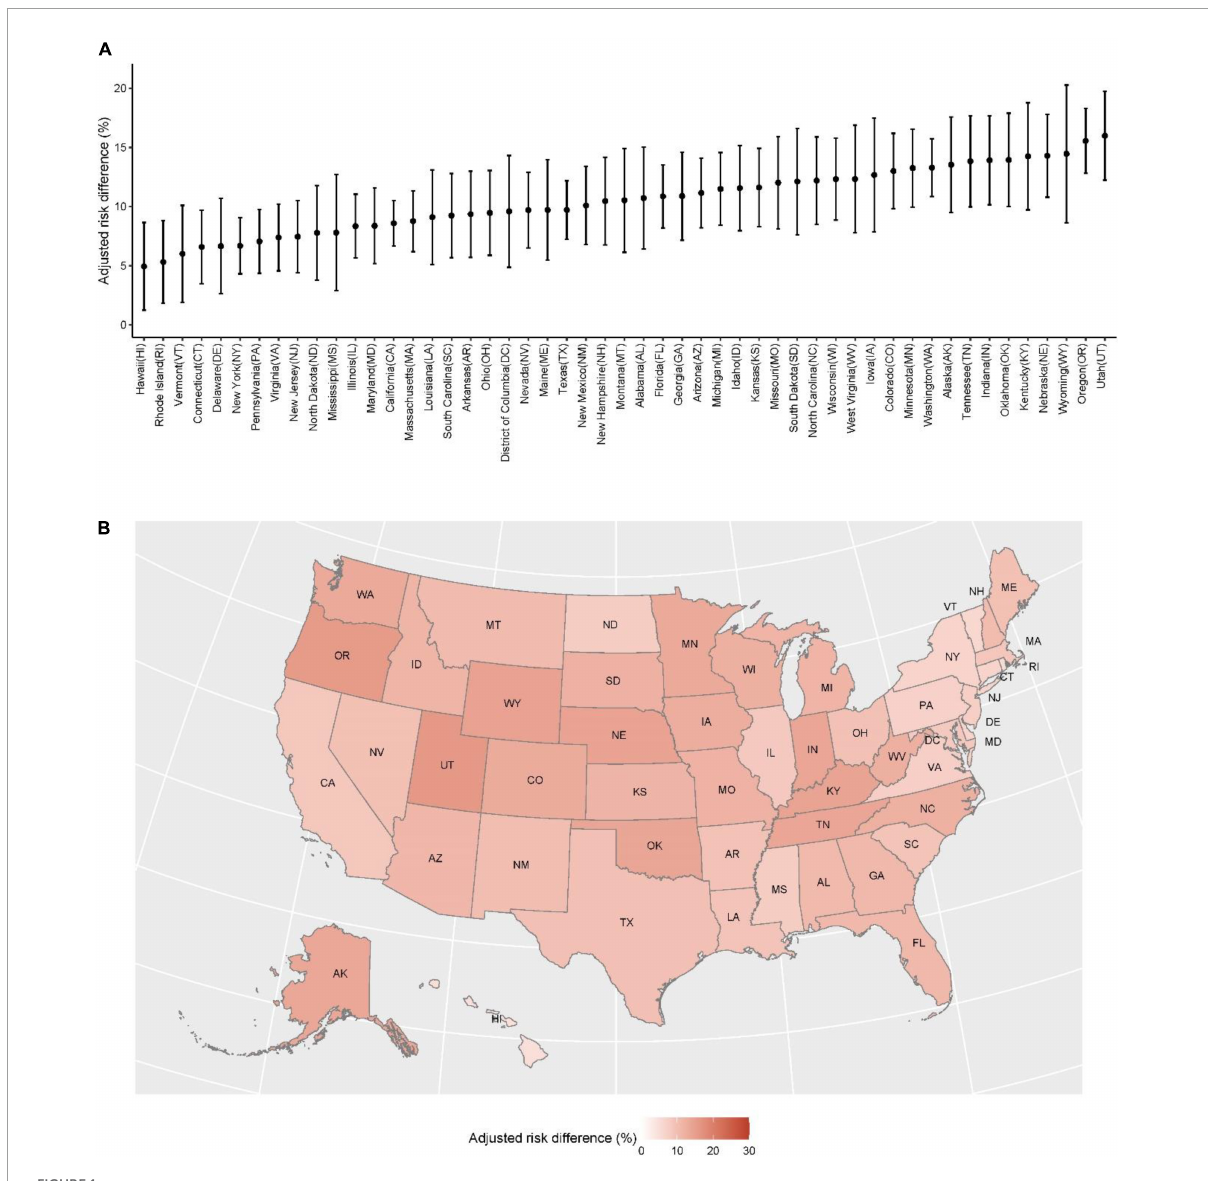
FIGURE1 Geographic variation in the difference in unmet mental health needs between LGBTQ+ and non-LGBTQ+ (as reference) by states from 21 July 2021 to 9 May 2022. (A) The point presents the adjusted risk differences and the vertical line presents the 95% confidence interval, both of which were extracted from multivariable logistic regression models with LGBTQ+ status (yes vs. no) as the key predictor, controlling for socio-demographics (age, race/ethnicity, marital status, and educational attainment), and affordability (household income, difficulty with expenses, availability of public health insurance, and availability of private health insurance). (B) Color presents the values of adjusted risk differences, the same as those in panel (A)